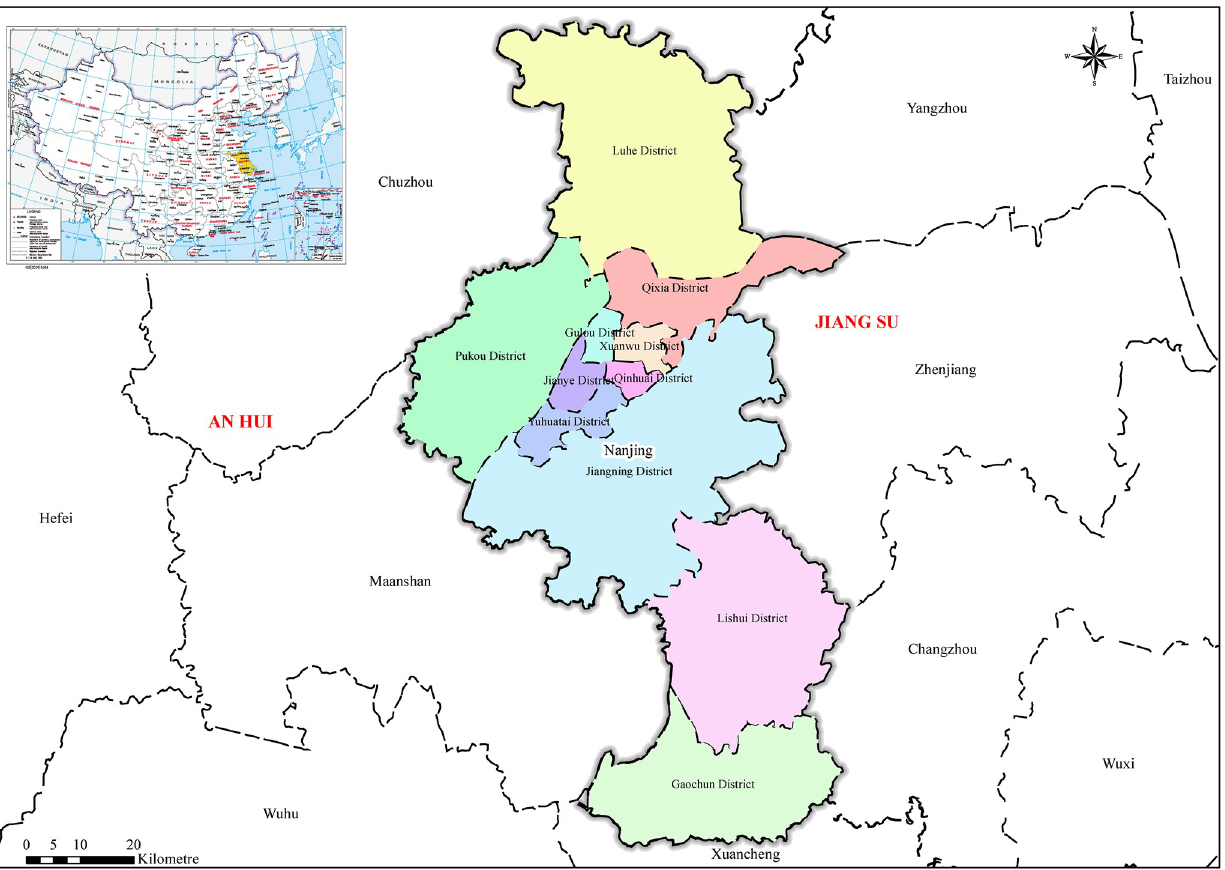
Fig 1. Location map of the study area. Attached figure: based on the standard map No. GS (2019) 1694 downloaded from the standard map service website of The Ministry of Natural Resources, with no modification.